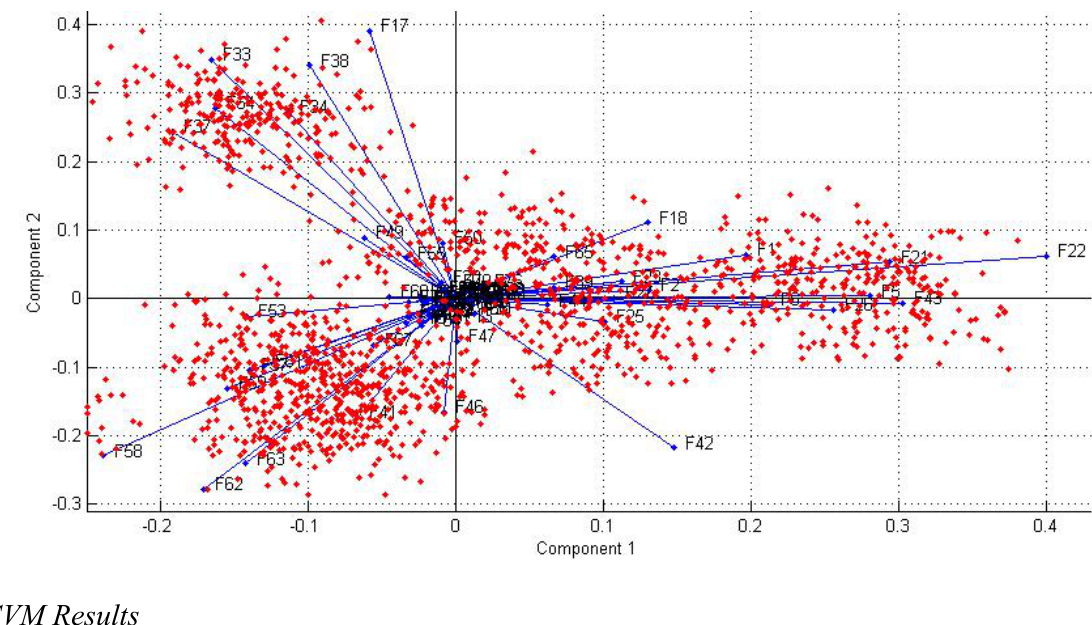
Figure 9. The biplot (red dots represent the samples, and blue lines represent the 79 original features, and x-axis & y-axis represent the two principal components).